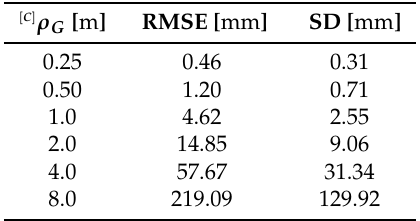
Table 4. Results of RMSE from Synthetic Triangulation Experiment.